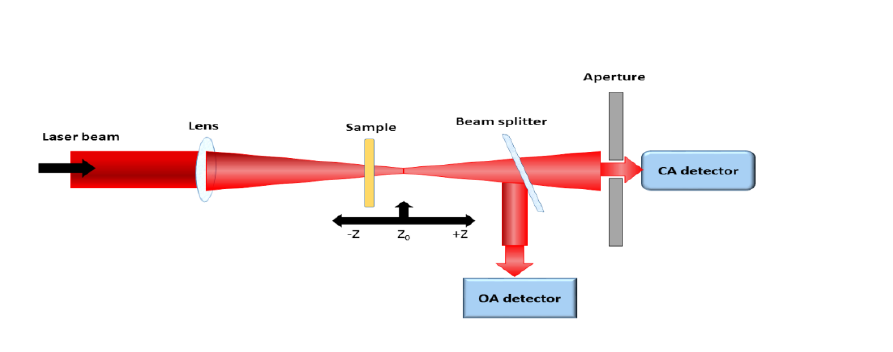
Fig.1: Experimental setup for the Z-Scan